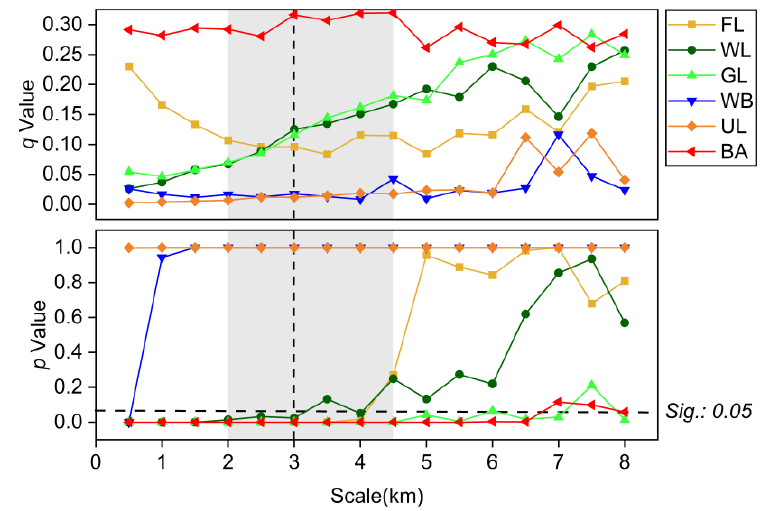
Figure 8. Scale effects of land use/land cover impact on ecological quality. p < 0.05 indicates a significant detection result.